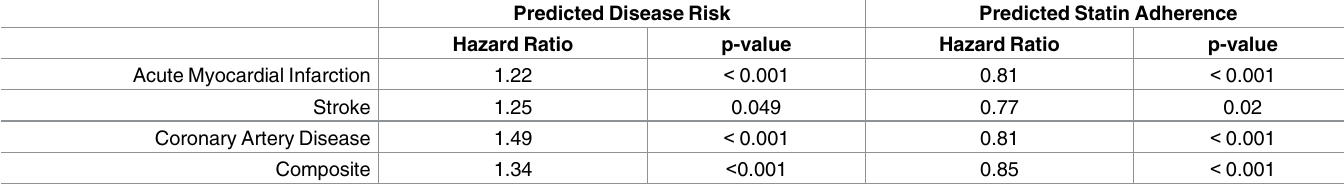
Table 4. Independent association between statin adherence model and cardiovascular disease hospitalization.